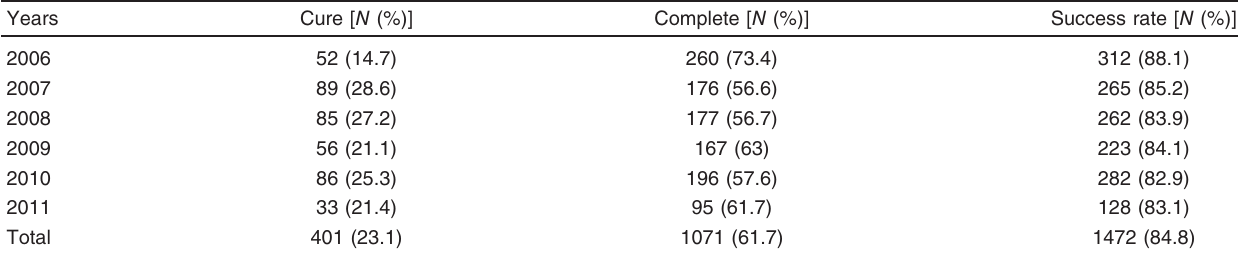
Table 10 Indicators of the success of directly observed therapy short-course (2006 – 2011) Years